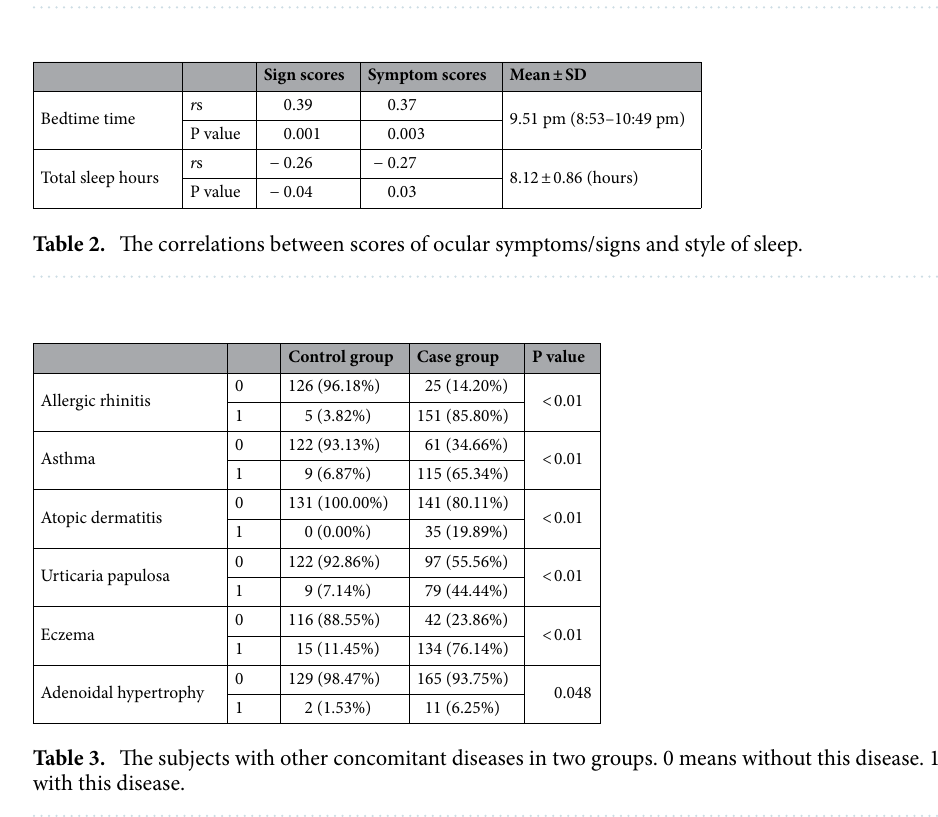
Table 1. The risk factors related to allergic conjunctivitis. *means without allergic history. **means with allergic history.